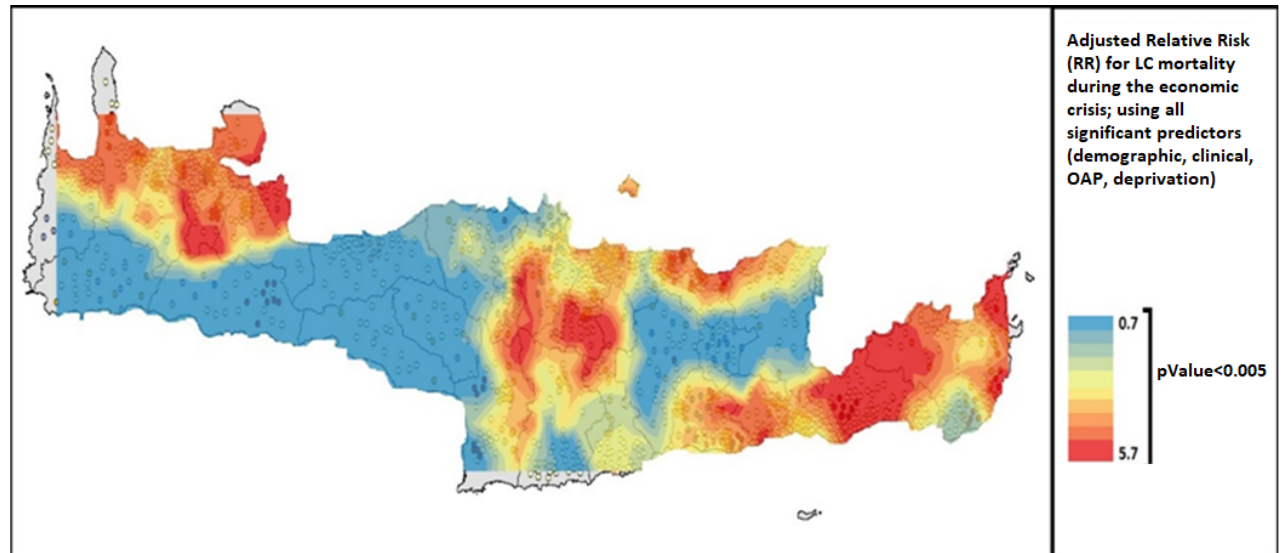
Figure 2. Risk for LC mortality during the economic crisis, testing for multiple significant predictors, ( n = 3599). ( n =